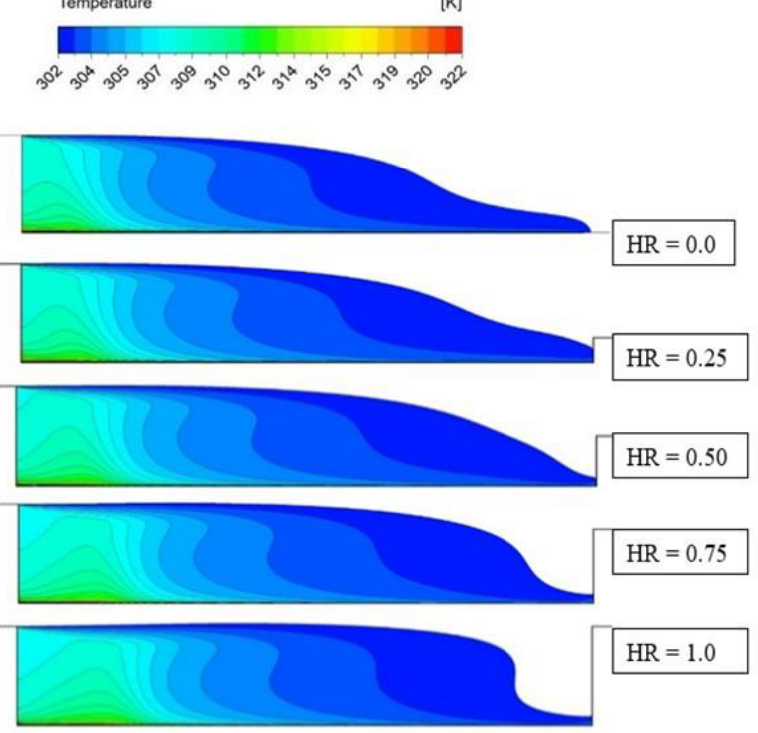
Figure 13. Temperature contours in a plane of symmetry for cavity at different height ratios (0.0 ≤ HR ≤ 1.0).